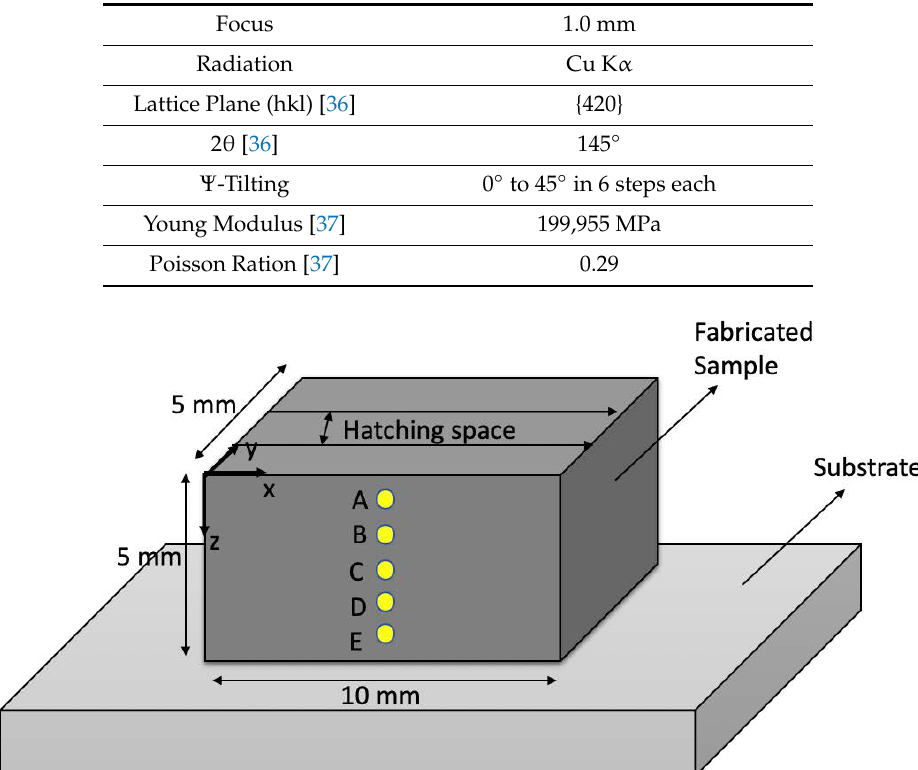
Figure 5. Predicted temperature field for the fabricated IN718 sample built via L-PBF with the laser power of 250 W, scan speed of 600 mm/s, layer thickness of 30 µ m , and hatching space of 100 µ m .